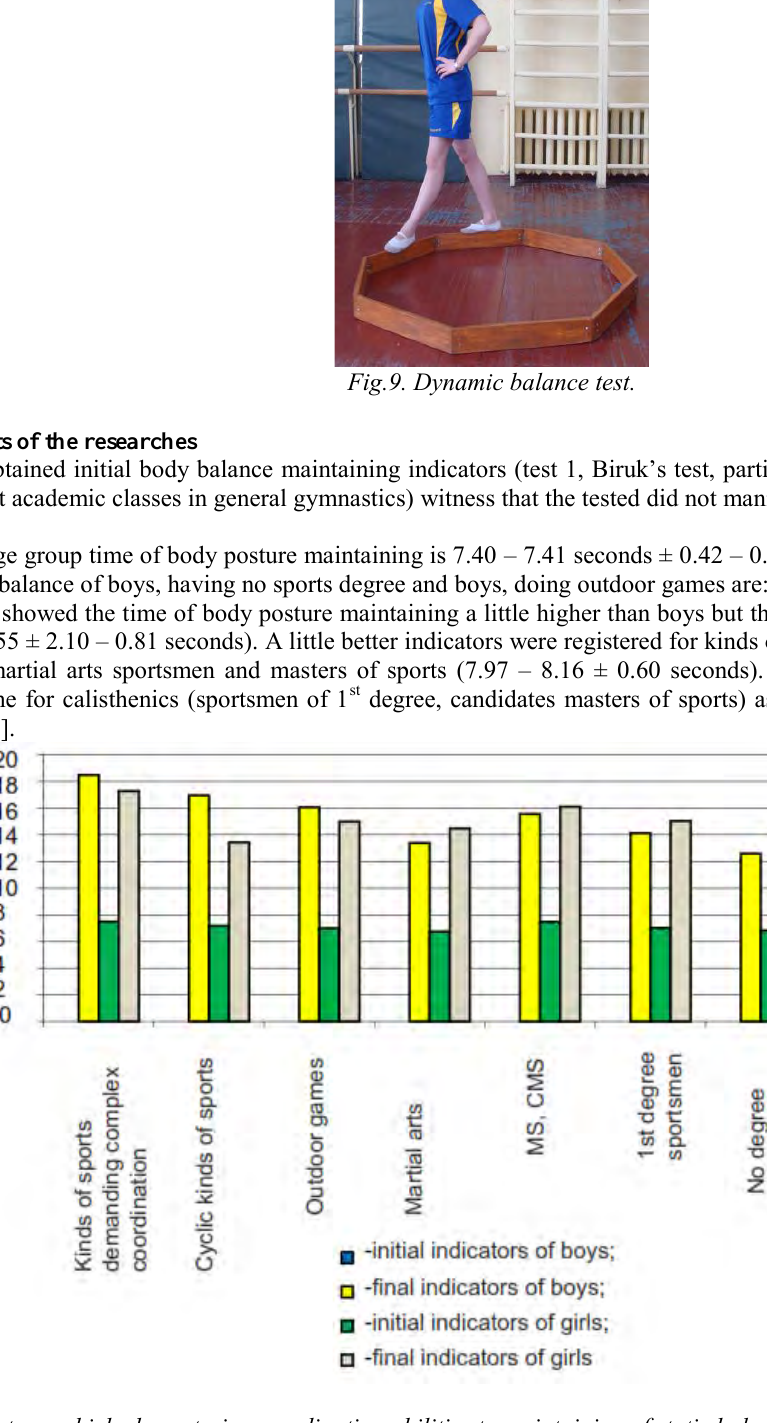
Fig. 10. Indicators, which characterize coordination abilities to maintaining of static balance by first year students of NU